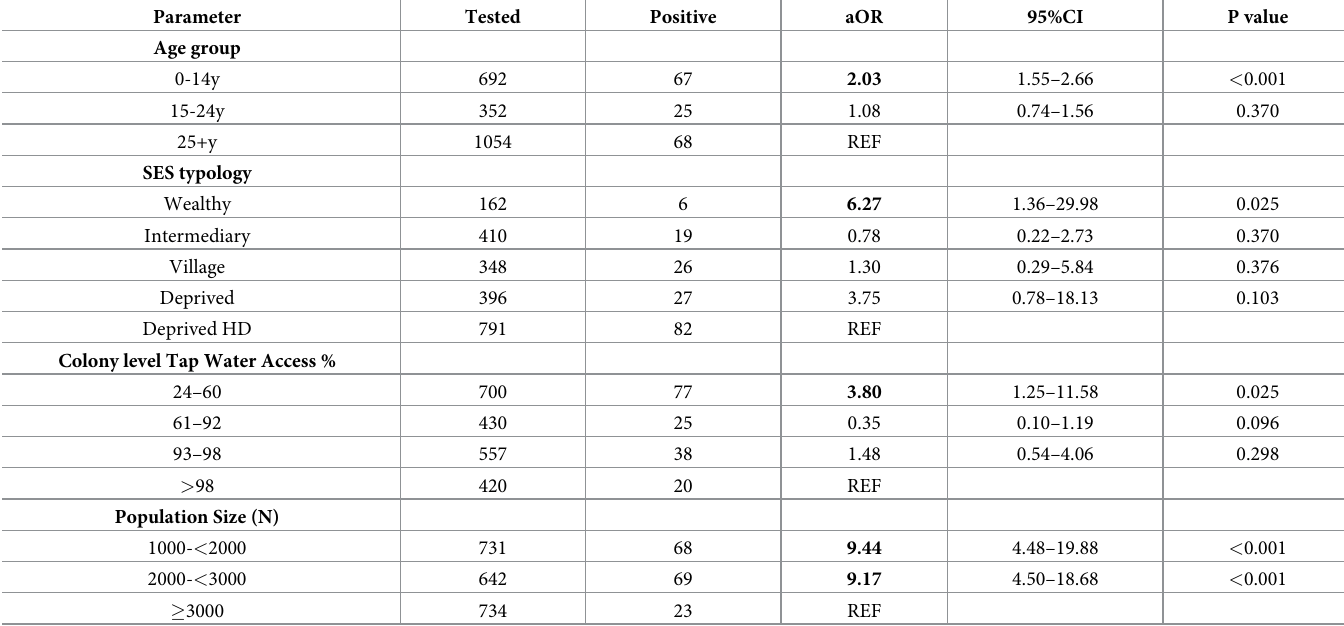
Table 1. Association of parameters with recent and/or primary dengue infection (IgM and/or NS1+ using SD Bioline Duo RDT) in the multivariate